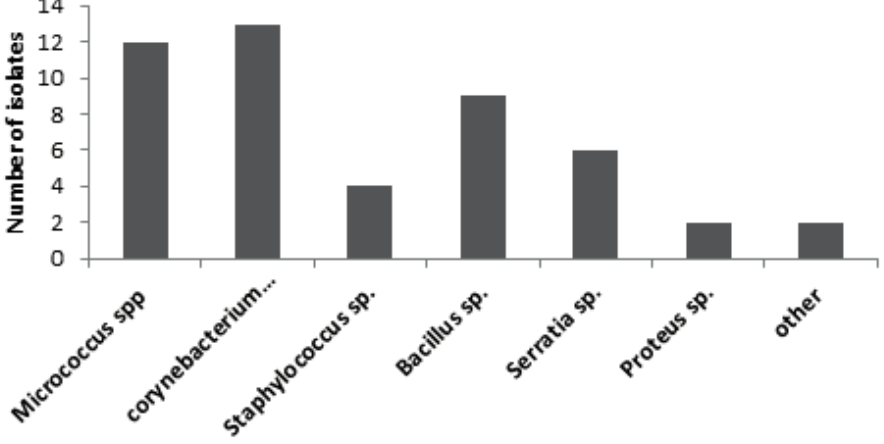
Figure 3. Distribution of bacterial isolates from collected